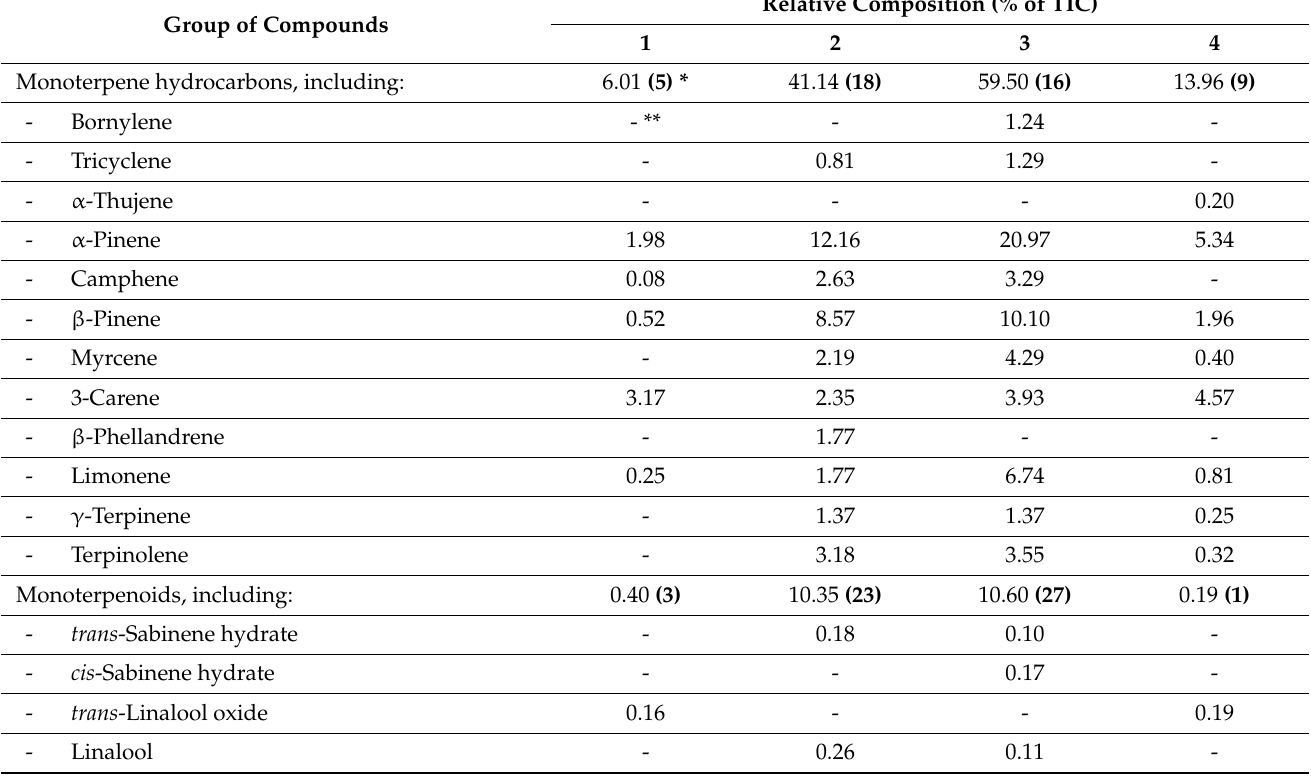
Table 2. Group composition of volatile compounds in Argentine propolis of stingless